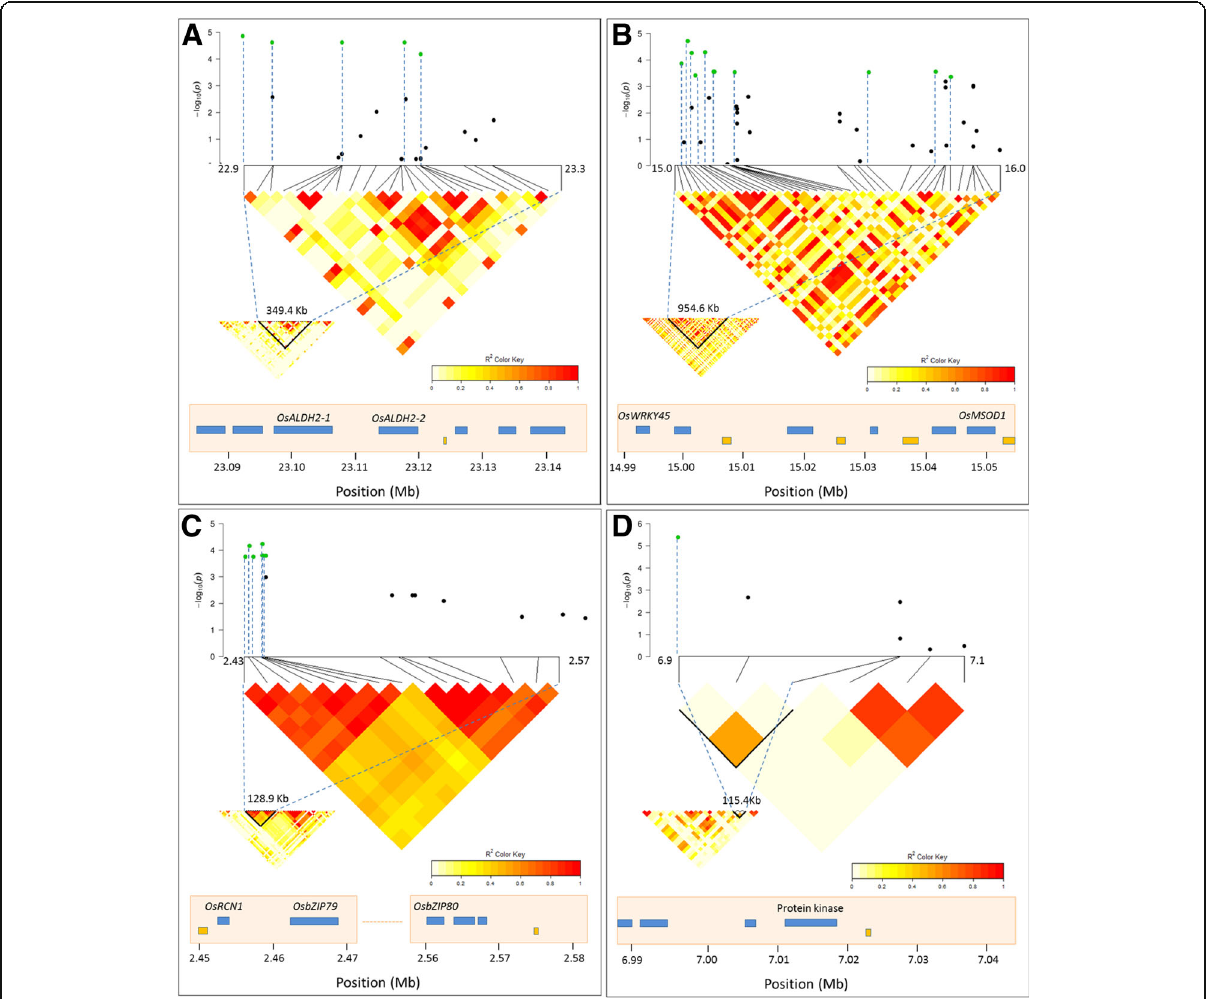
Fig. 6 Manhattan plots and Linkage Disequilibrium (LD) heatmaps for some strong QTLs. a Score3 across q1 in the indica subpanel; b Score4 across q4 in the full panel; c RWC_T2 across q12 in the indica subpanel; d RWC_T1 across q14 in the full panel. The well-known genes of interest in these regions are also